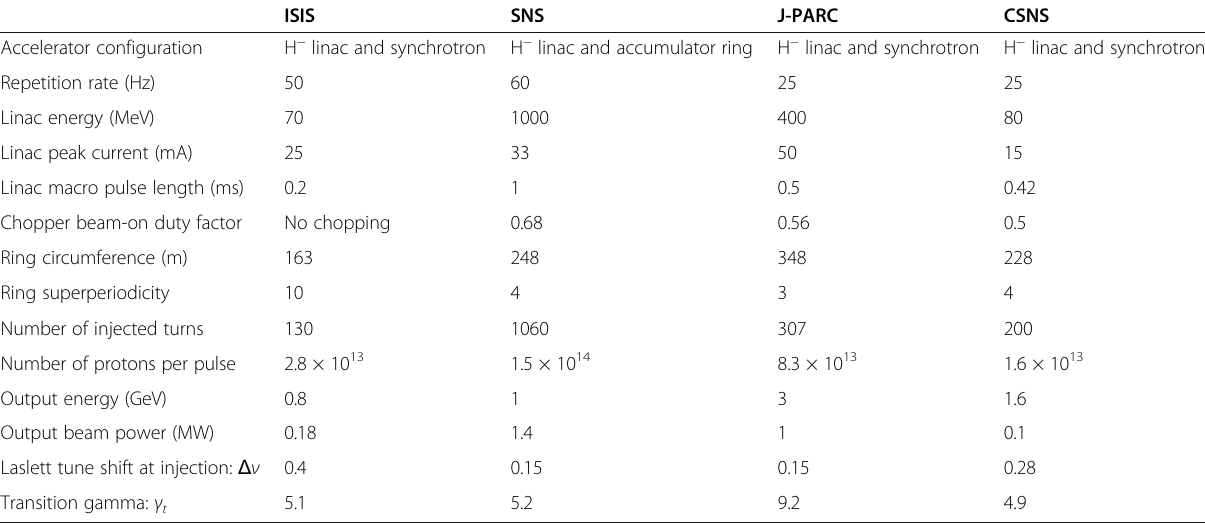
Table 1 Main parameters of the high-power proton accelerators currently in operation for the major existing pulsed spallation neutron source facilities ISIS SNS J-PARC CSNS Accelerator